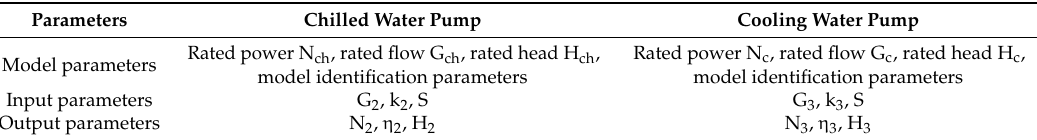
Table 13. Parameters of custom chilled water pump module.